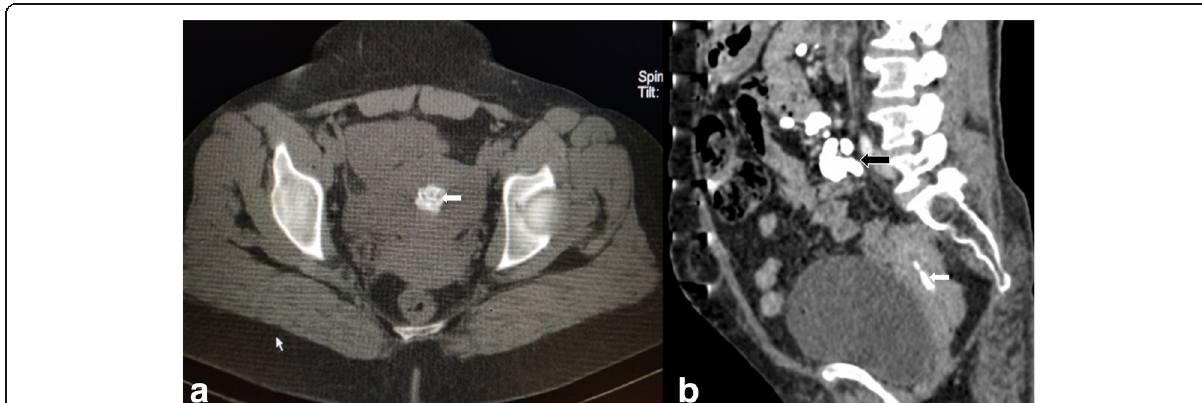
Fig. 5 Axial (a) and sagittal (b) non-contrast CT images of pelvis and lower abdomen in a 30-year-old infertile patient with a history of old pulmonary tuberculosis and recurrent abdominal pain revealing dense endometrial calcification (white block arrows) with Hounsfield attenuation of 520 HU similar to adjacent pelvic bone and calcified retroperitoneal nodes (black block arrow). Subsequent HPE clinched the diagnosis of calcific endometritis